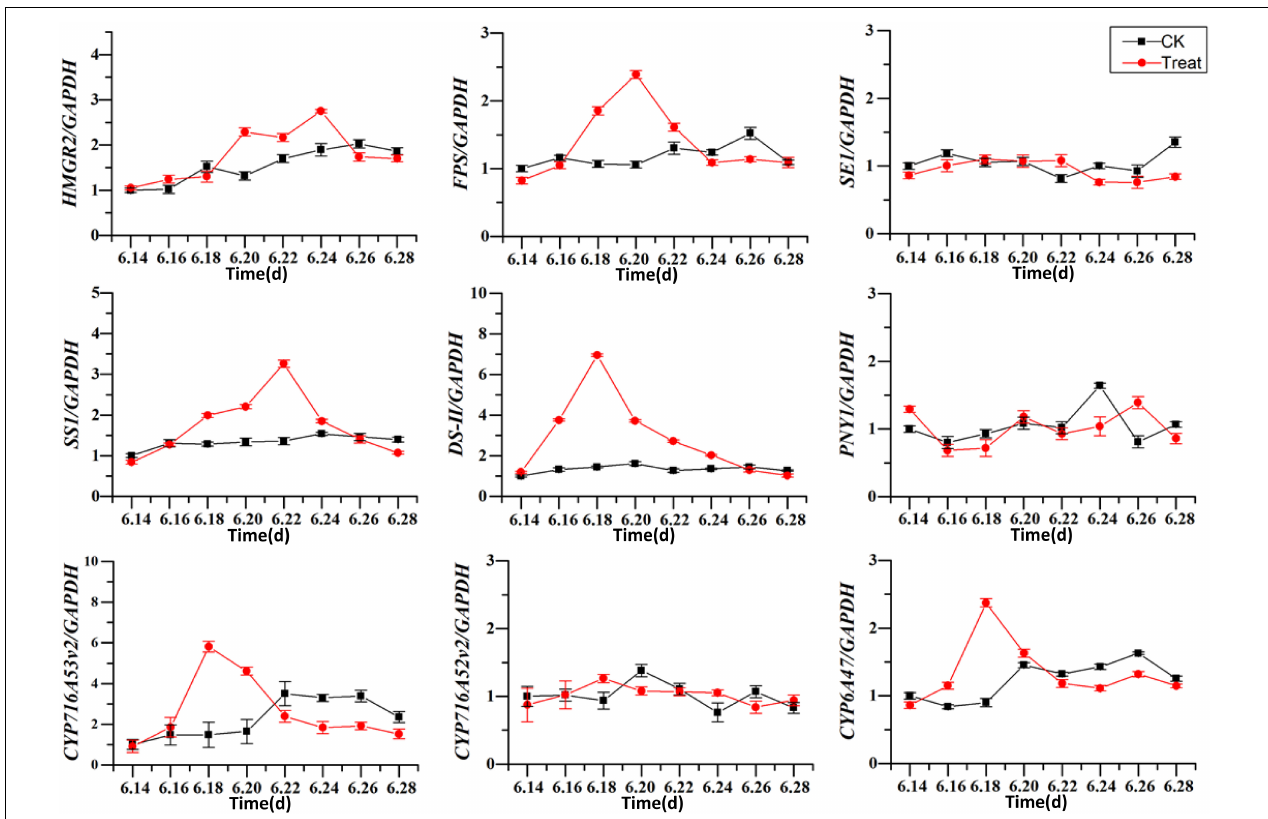
FIGURE 11 | Effects of cold stress on the expression of key enzyme genes. The X axis represents the sampling time. * p < 0.05 and ** p < 0.01, compared with control group. The data are expressed as the mean ± SD ( n =